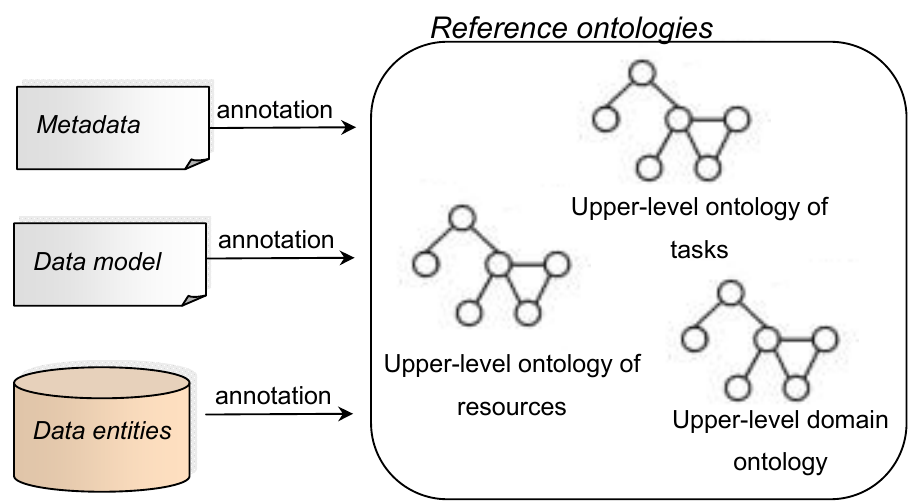
Figure 5. Framework for semantic annotation (adapted from